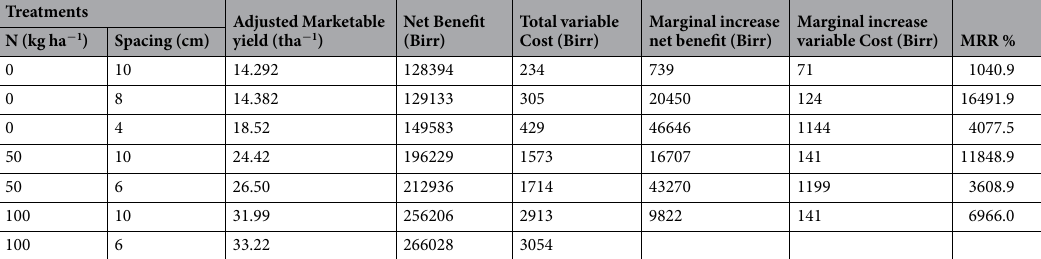
Table 5. Analysis of marginal rate of return. MRR is calculated by dividing the marginal increase in net benefit with the marginal increase in variable cost and multiplied by